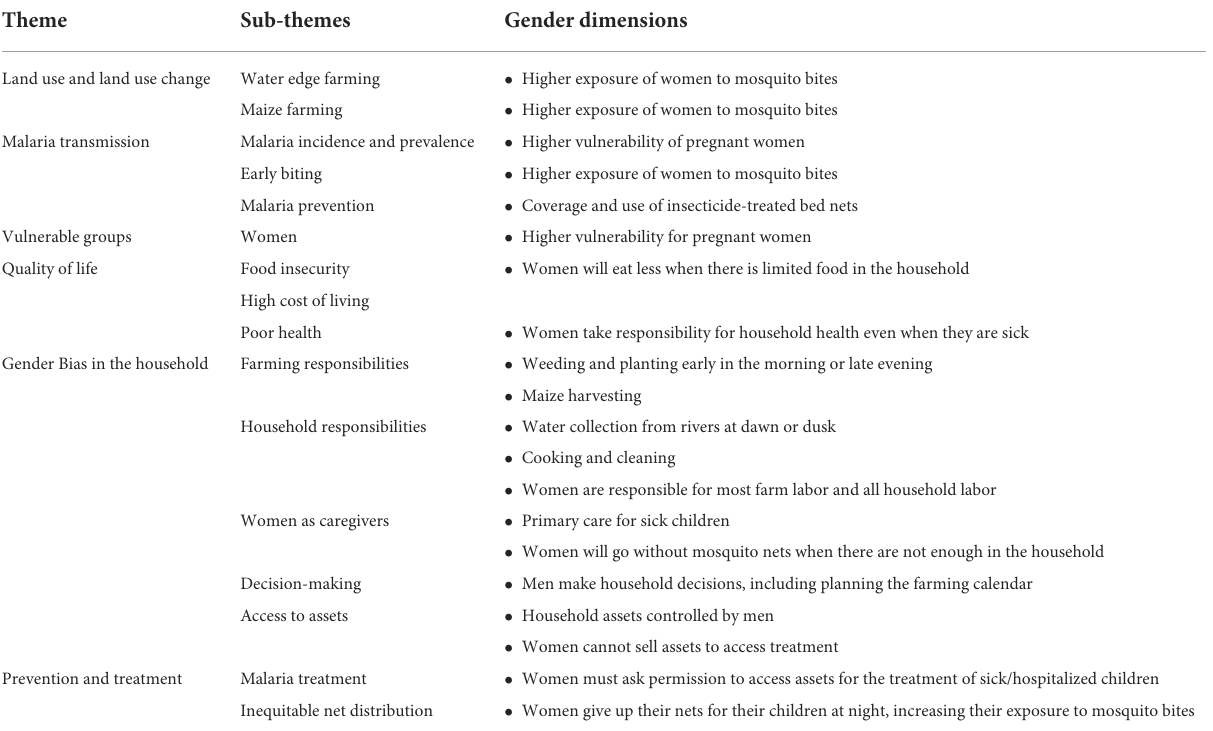
TABLE 1 Gendered dimensions of exposure, vulnerability, and response among identified themes and sub-themes. Theme Sub-themes Gender